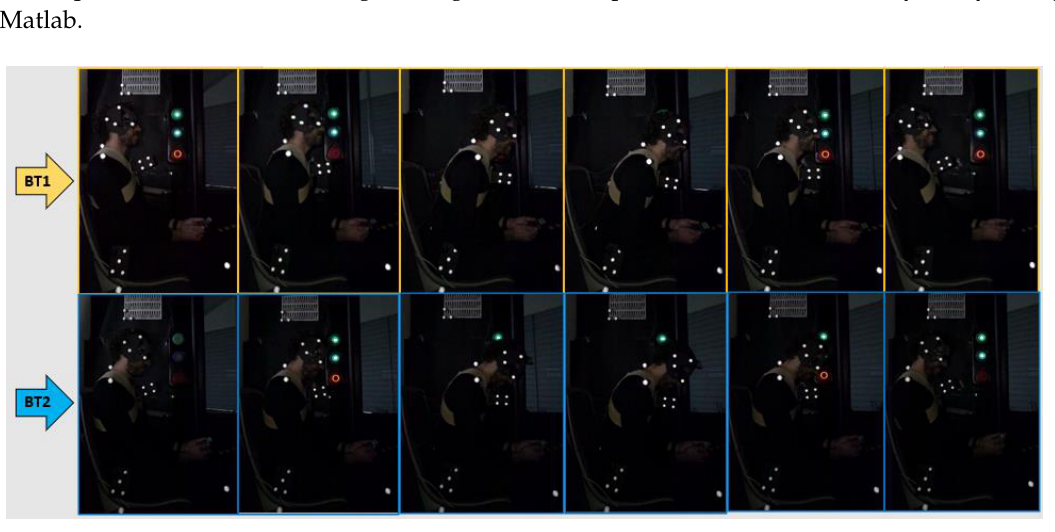
Figure 9. Movement of one volunteer during BT1 and BT2.